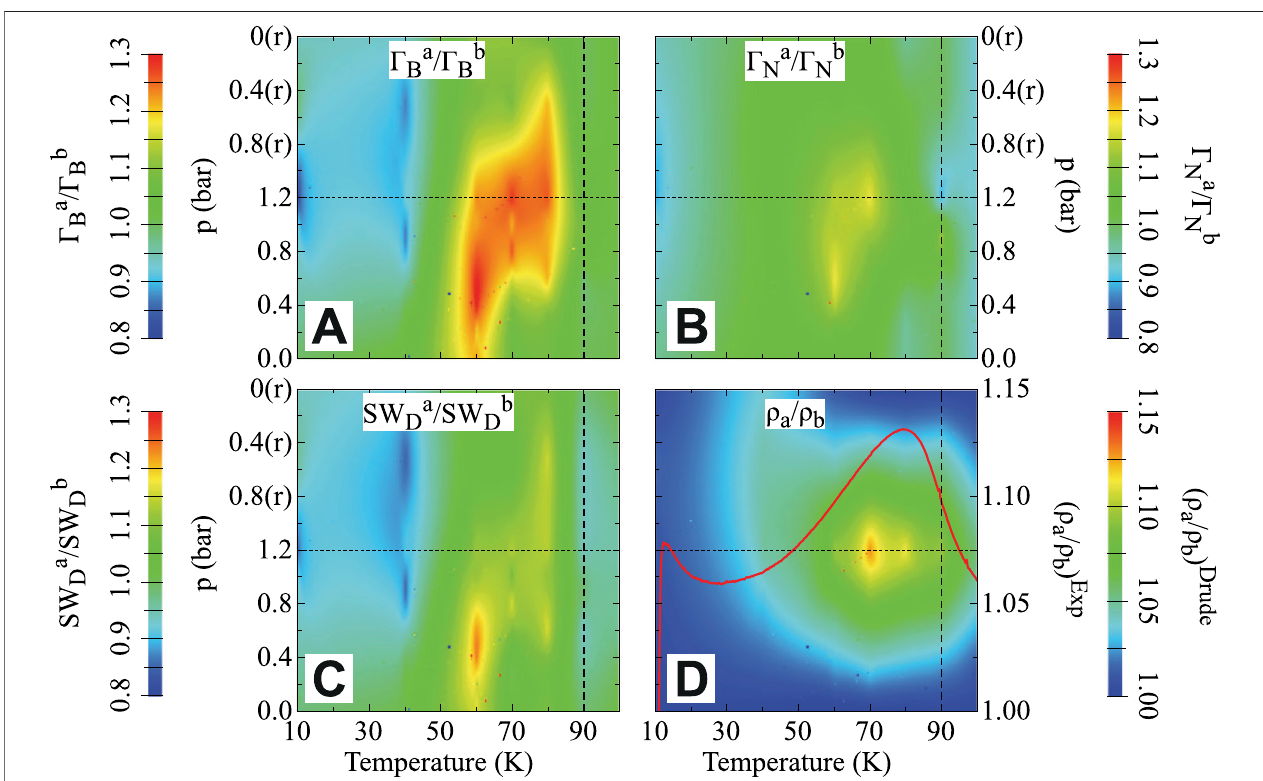
FIGURE5| (coloronline) (A – C) T and p dependenceoftheanisotropyofboth scattering rates ( Γ a N , B / Γ b N , B ) forthebroad(B)andnarrow(N)Drude components and of the total Drude weight ( SW a D / SW b D ) from the phenomenological fi t ( Eq. 1 ) of the p -loop experiments after the ZPC protocol (see text) in FeSe. (D) T and p (left scale) dependenceofthe dc anisotropy( ρ a / ρ b )calculatedwithintheDrudemodel.A fi rst-neighborinterpolationprocedureisusedinordertogeneratethecolormaps.Released p isdenoted by “ (r) ” .Thethick vertical dashed linemarks T s ,whilethethinhorizontal dashed lineindicates p =1.2 bar (i.e.,at saturation). Thered curve inpanel (D) corresponds to the experimental ρ a / ρ b (right scale) for fully detwinned specimen [34]. Reproduced from Ref. [26].